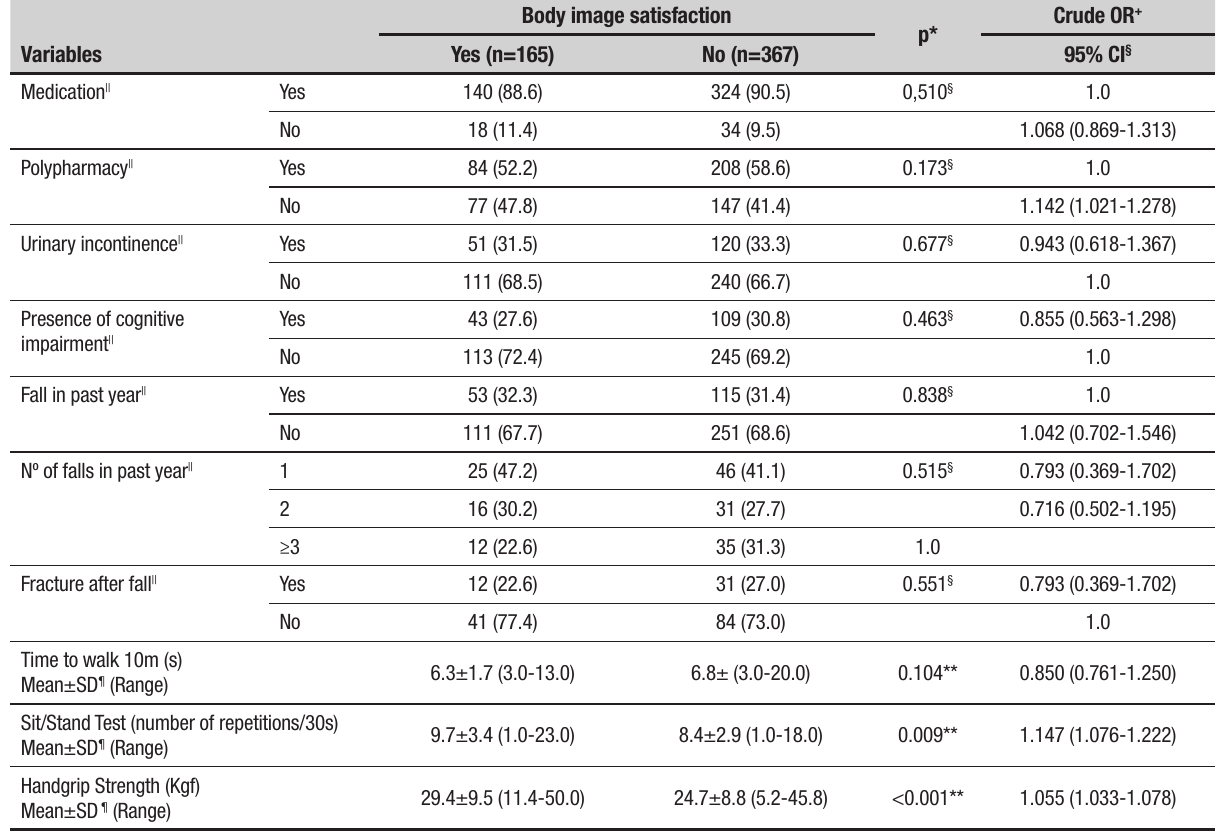
Table 3. Clinical and functional characteristics of sample according to body image satisfaction.